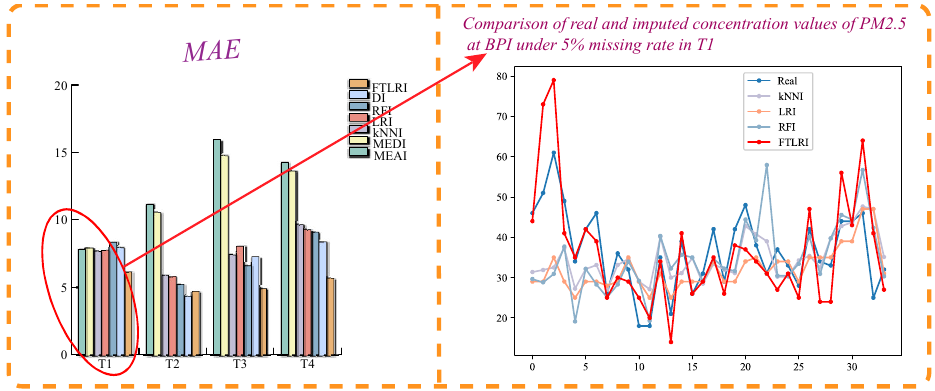
Figure 6. MAE of imputation results of PM 2.5 at BPI under 5% missing rate.